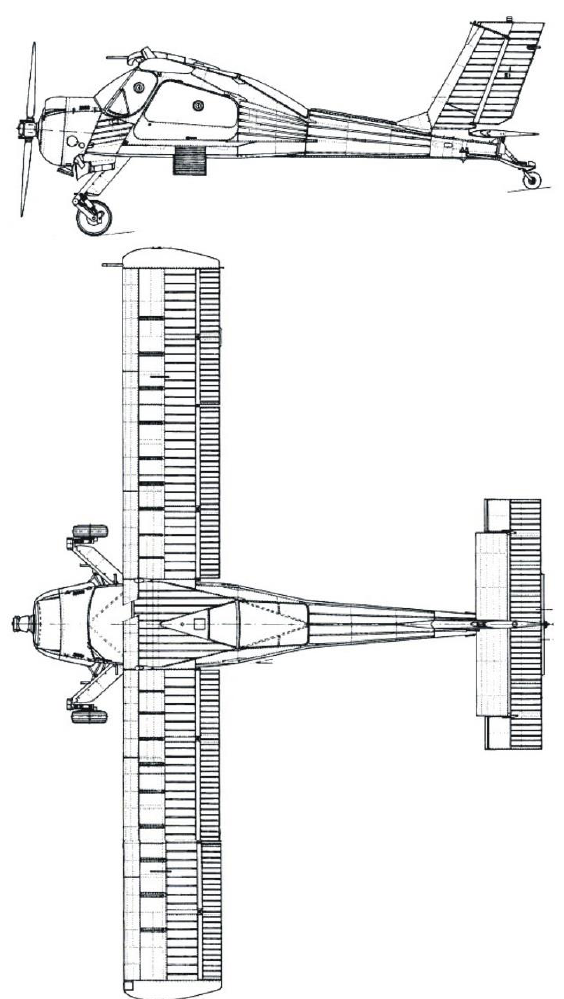
Figure 4. The PZL 104 Wilga 35A, used for the tests.